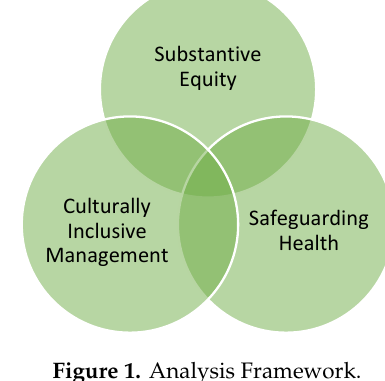
Figure 1. Analysis Framework.